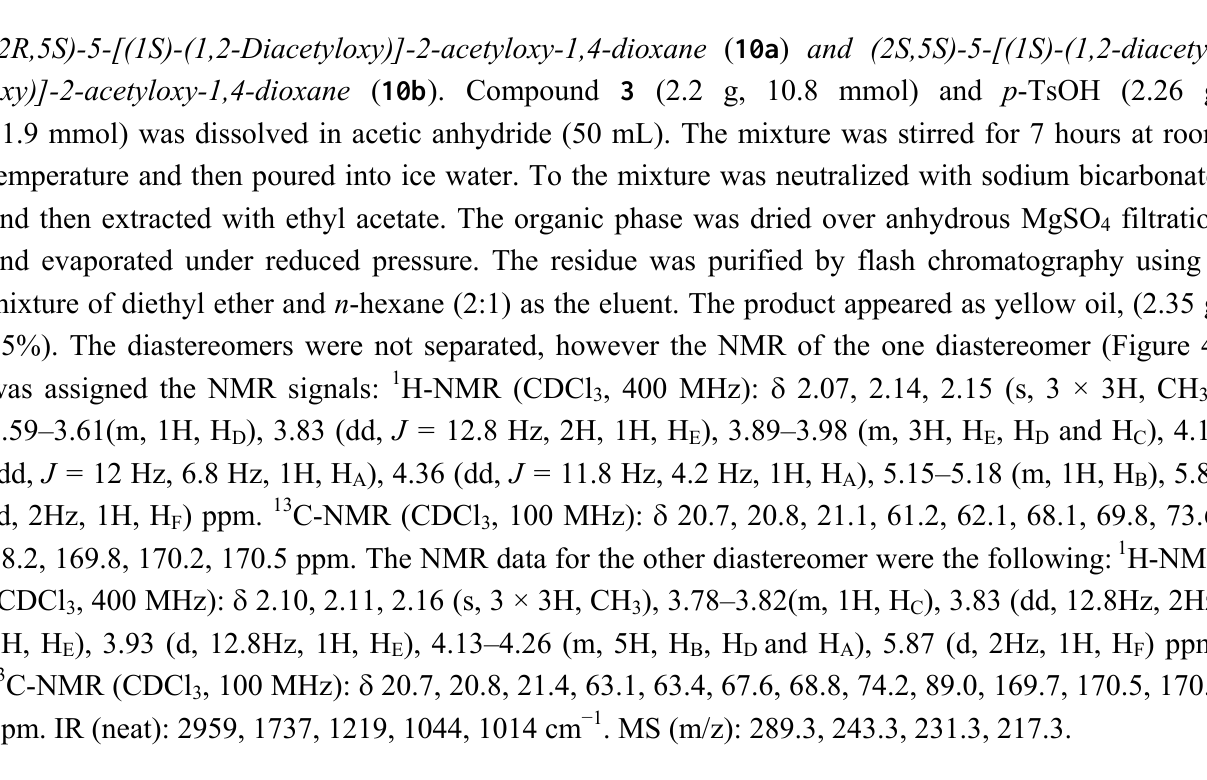
Figure 4. Structure of compound 10